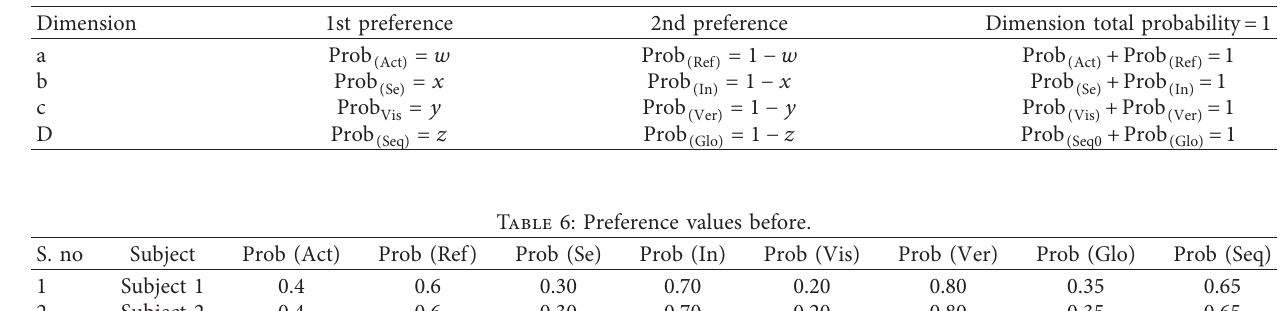
Table 5: Representation of preferences’ probabilities.